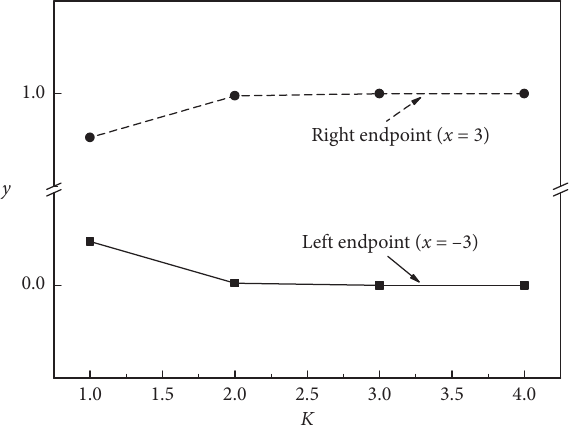
Figure 11: Deviation of different K values at two